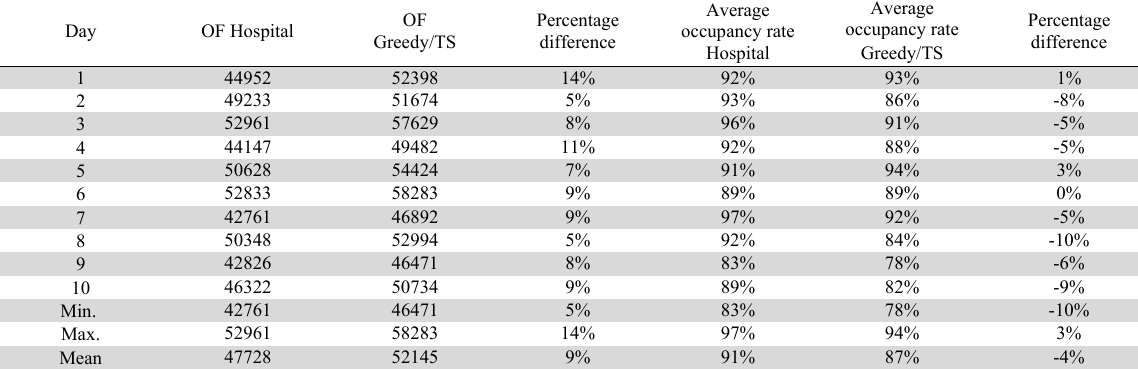
Comparison between real life instances, Greedy Algorithm and